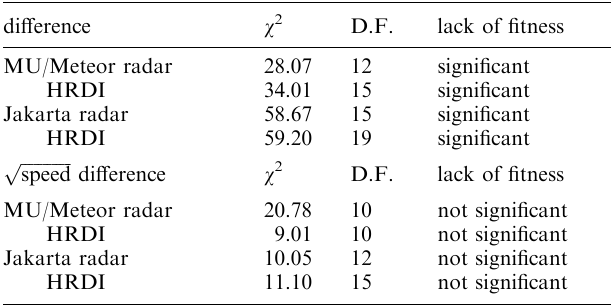
Table 2. Goodness of fit in the normal distribution (significance level 0.01)